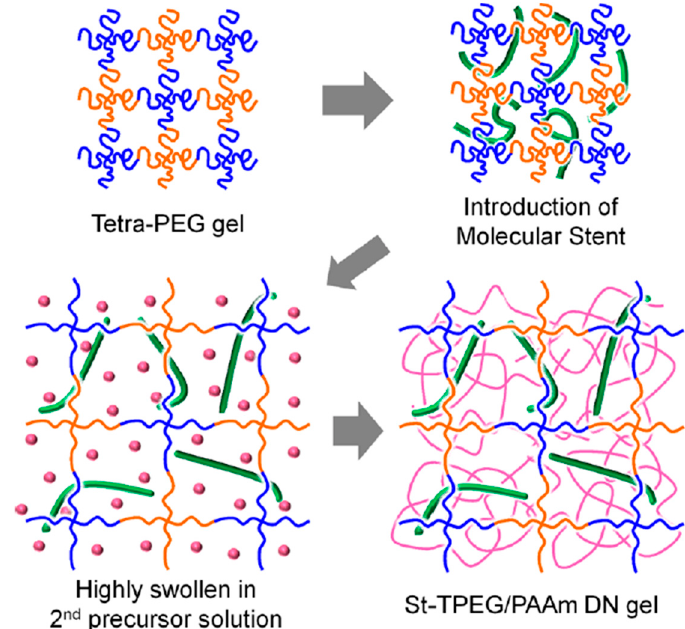
Figure 8. Schematic representation of the procedure followed for the preparation of the triple-network (TN) hydrogels based on a well-defined four-arm poly(ethylene glycol) star (tetraPEG) gel first polymer network. After its preparation, the first network was immersed in the ionic 2-acrylamido-2-methylpropane sulfonic acid (AMPS) monomer solution, and after its photopolymerization, the resulting double-network (DN) hydrogel was immersed in an aqueous acrylamide (AAm) / N , N’ -methylenebisacrylamide (MBAAm) solution and photopolymerized to prepare the final TN hydrogel. Adapted and reprinted with permission from [22]. Copyright 2013 ACS Publications American Chemical Society.